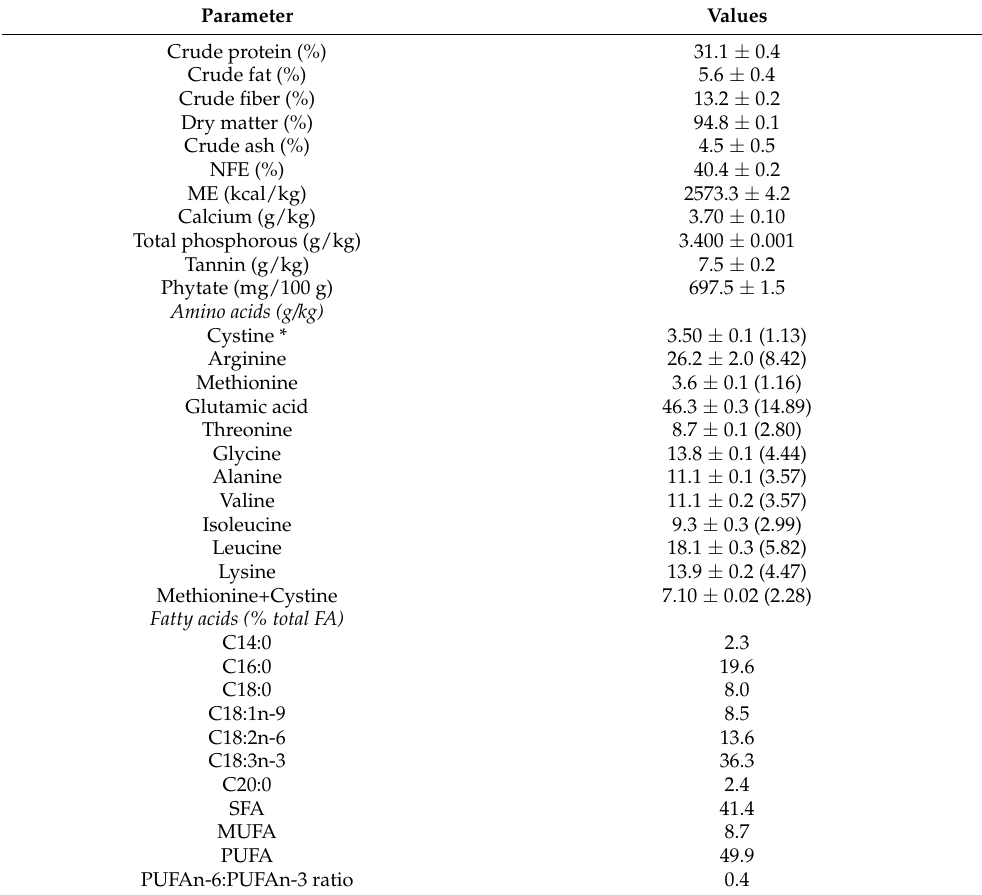
Table 1. Chemical composition of Leucaena seeds